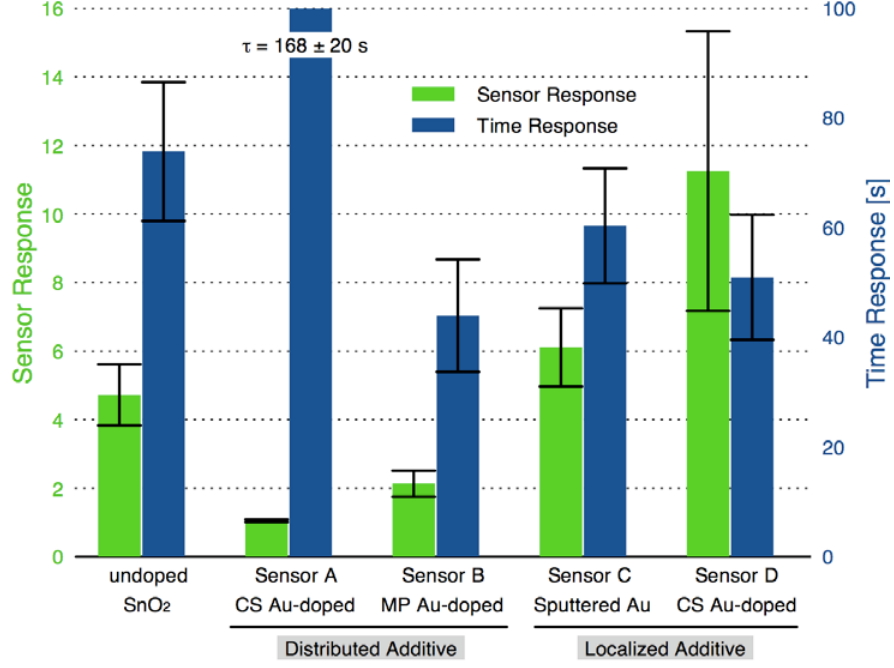
Figure 8. Comparison of sensor response and time response of the distributed and localized Au additive architectures for sensor operating temperature of 330 o C.